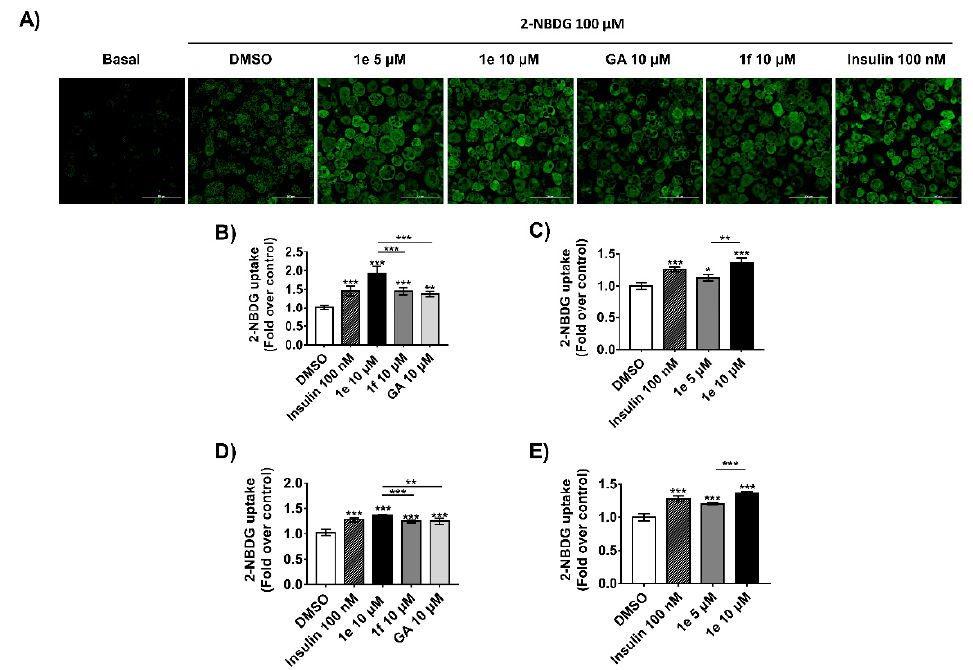
Figure 4. GA and its analogs improved glucose uptake in differentiated 3T3-L1 adipocytes and C2C12 myotubes. After differentiation, mature 3T3-L1 adipocytes were incubated with 0.1% DMSO (the control for basal fluorescence) and 100 nM insulin (the positive control), with GA (10 µM), 1e (5 or 10 µM), or 1f (10 µM) as the test compounds in glucose-depleted media supplemented with